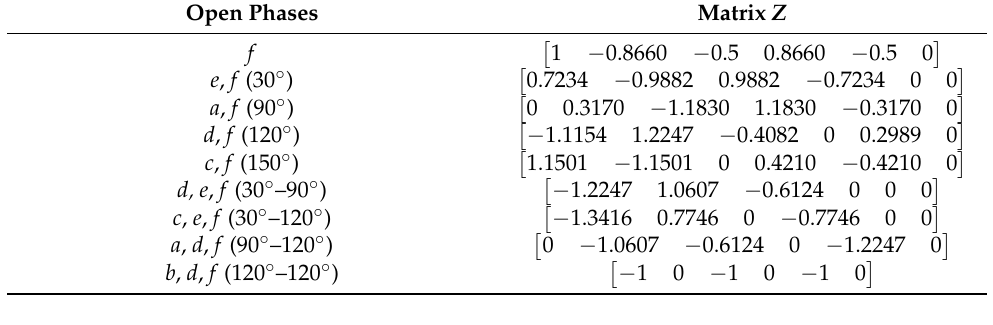
Table 8. Matrix Z under One to Three-Phase-Open Fault Cases.